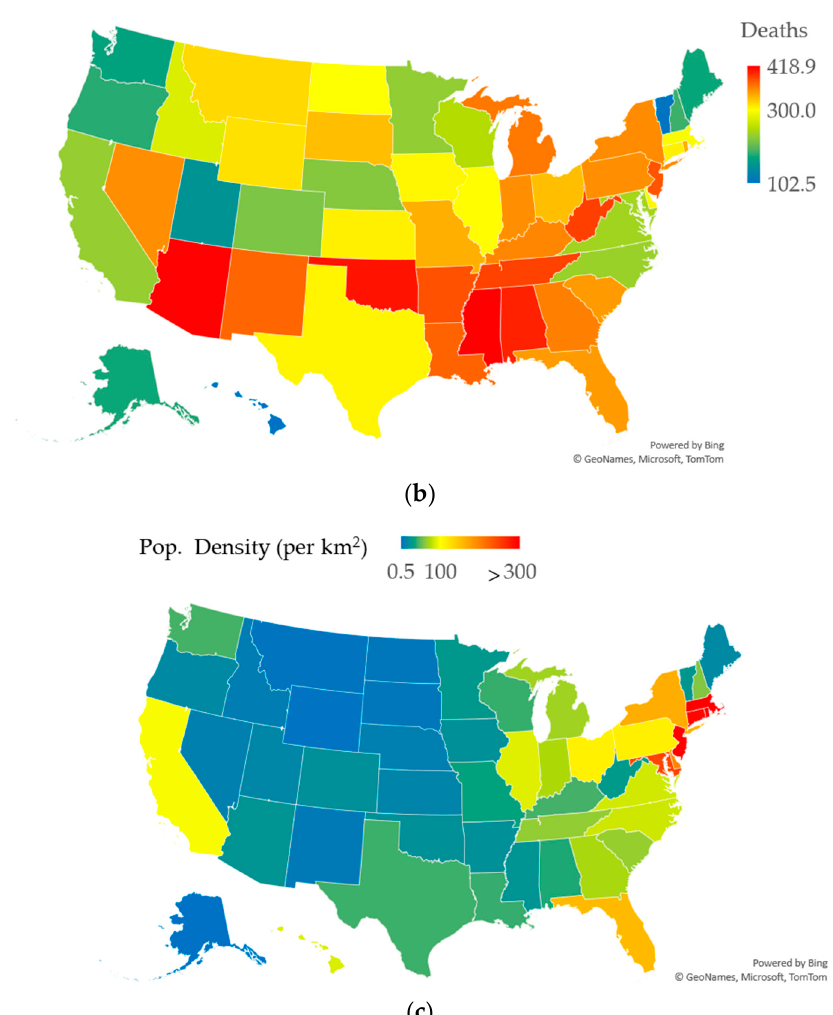
Figure 1. US COVID-19 statistics per 100,000 people as of December 2021 by state: ( a ) cases; ( b ) deaths; ( c ) population density [6,25,26].